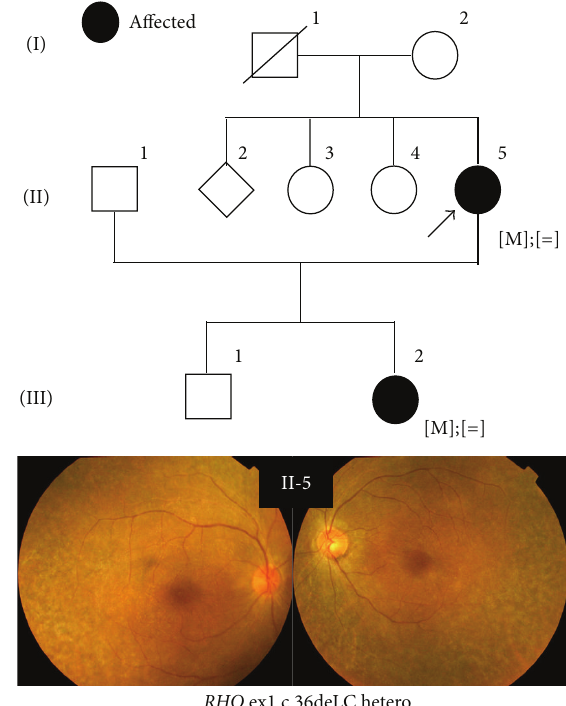
Figure 4: A pedigree of probable adRP with a novel RHO mutation. A family with a novel RHO mutation c.36delC is shown. II-5 in this family carried the heterozygote mutation, and her clinical phenotype was relatively mild with late onset at her age of 62. III- 2 showed only marginal clinical signs of RP when she underwent clinical evaluations at the age of 44. A possible carrier of I-1 died before the age when the III-2 presented RP symptoms. Affected individuals are indicated as filled symbols, and an arrow indicates the proband in this family. Bottom images are fundus pictures of II- 5.